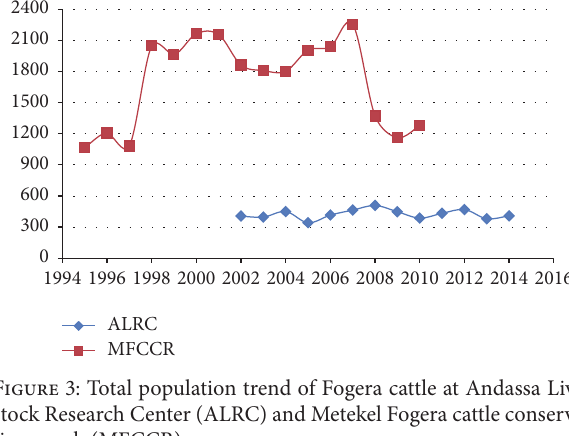
Figure 3: Total population trend of Fogera cattle at Andassa Live- stock Research Center (ALRC) and Metekel Fogera cattle conserva- tion ranch